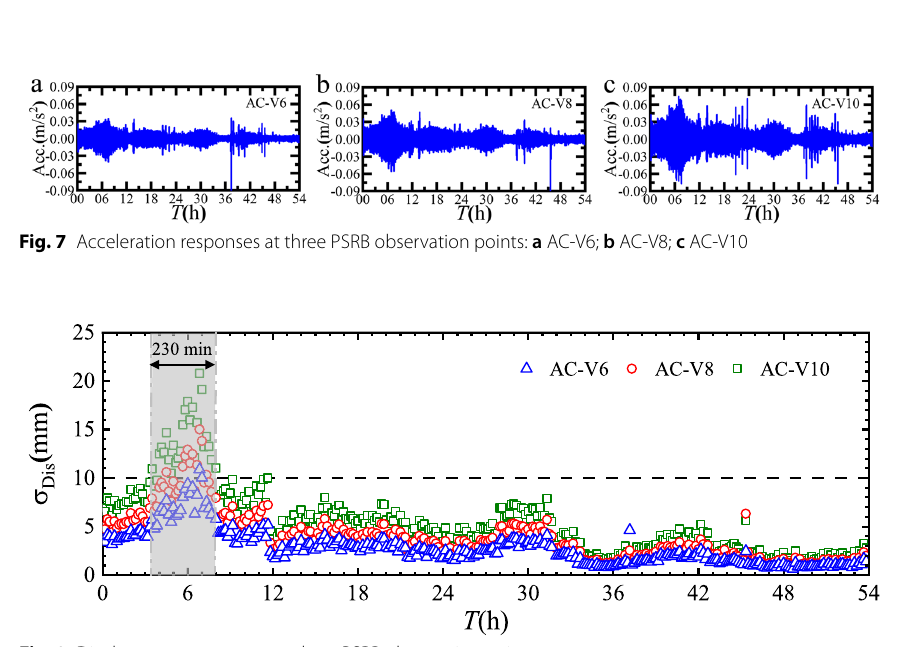
Fig. 8 Displacement responses at three PSRB observation